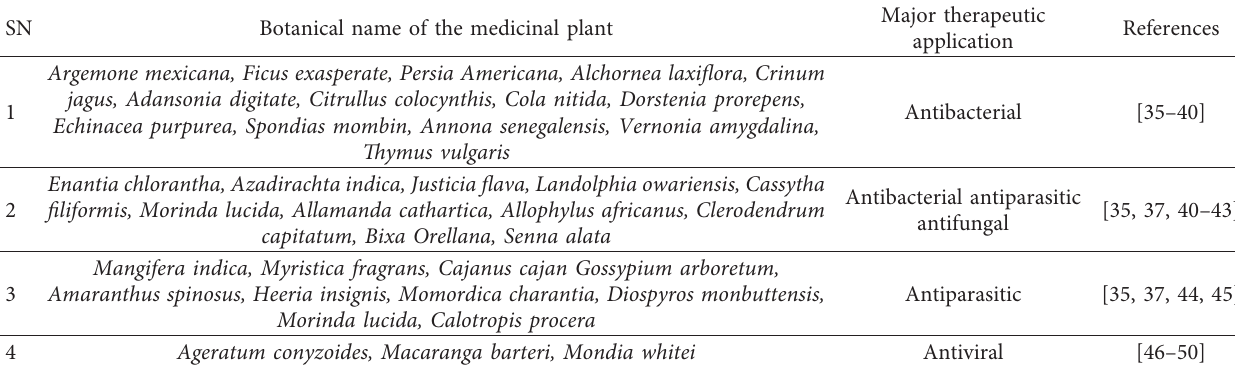
Table 1: Summary of selected antimicrobial medicinal plants in